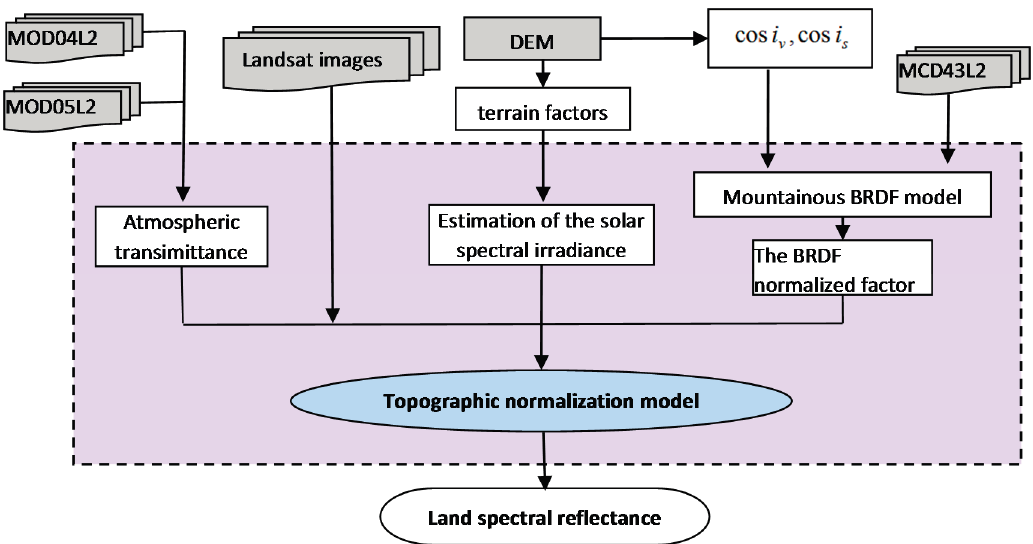
Figure 1. Flowchart of the improved